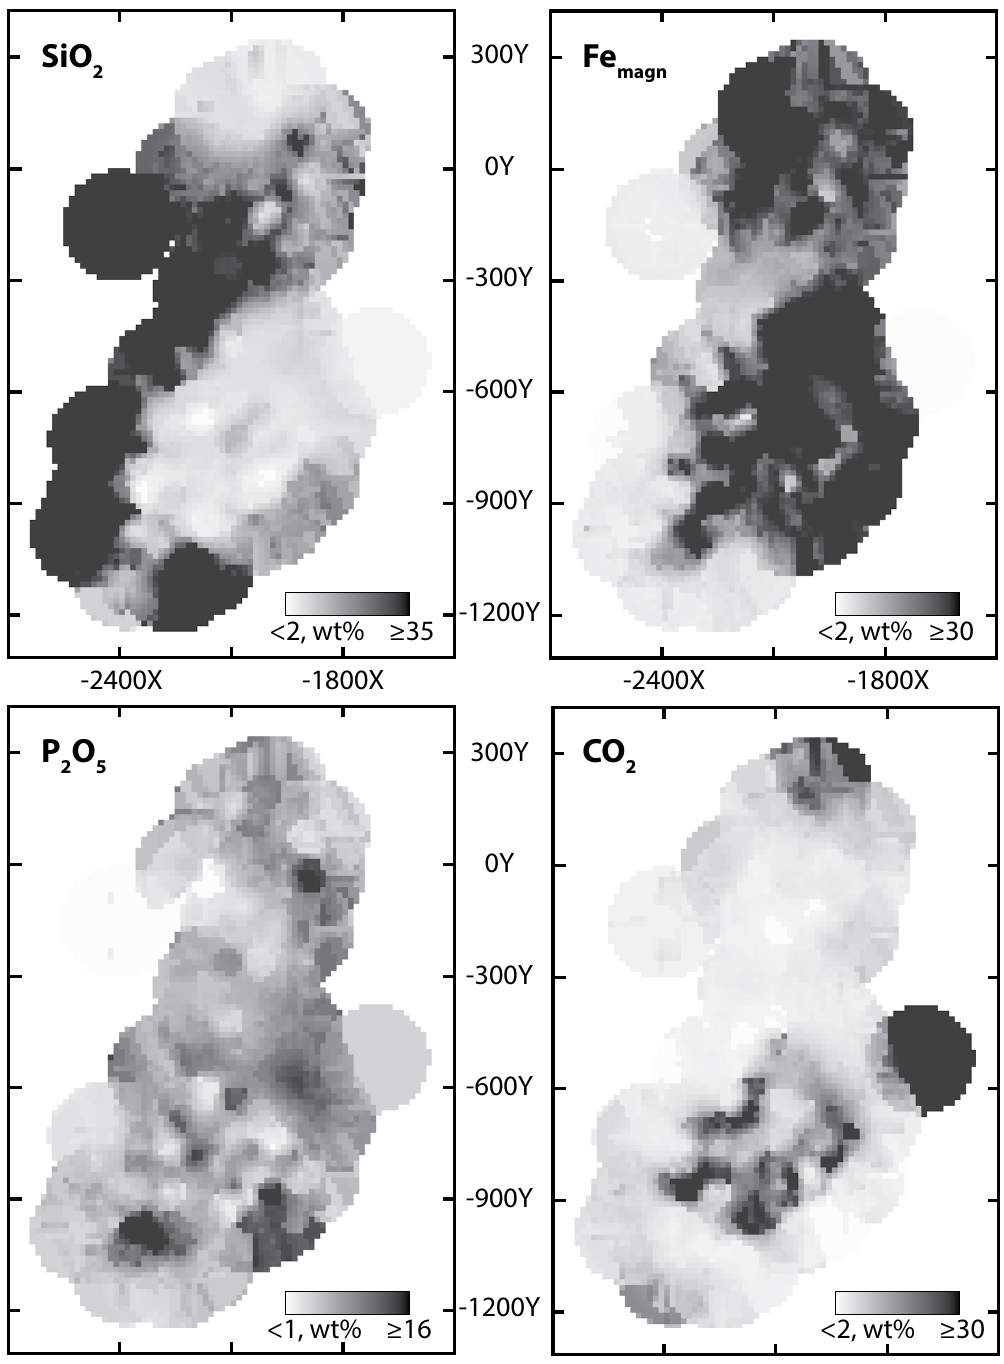
Figure 5. Spatial distribution of SiO 2 , Fe magn , P 2 O 5 , CO 2 concentrations in rocks. Horizontal section, level − 100 m. The maps were generated by Micromine 2016, commercial license